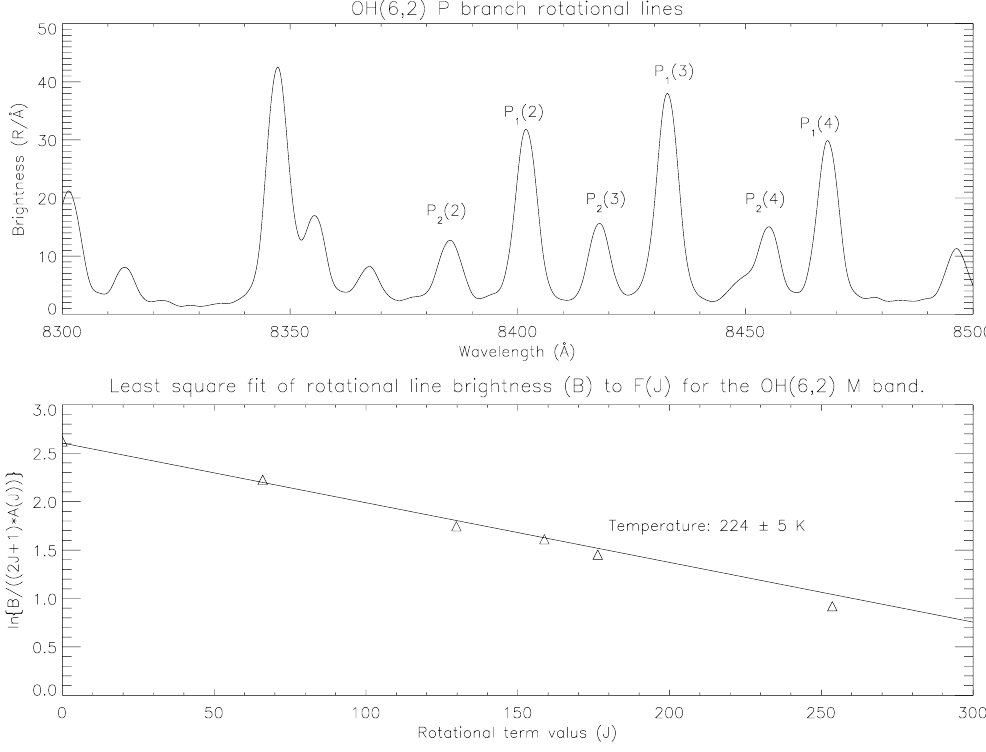
Fig. 1. Top panel: Rotational lines from the P branch of the airglow OH (6,2) band recorded by the South Pole CCD spectrograph. Bottom panel: Linearized plot of the first six rotational lines of OH (6,2) P branch shown as a function of F(J) and the linear least squares fit to the peak brightness of the rotational lines from which the temperature is